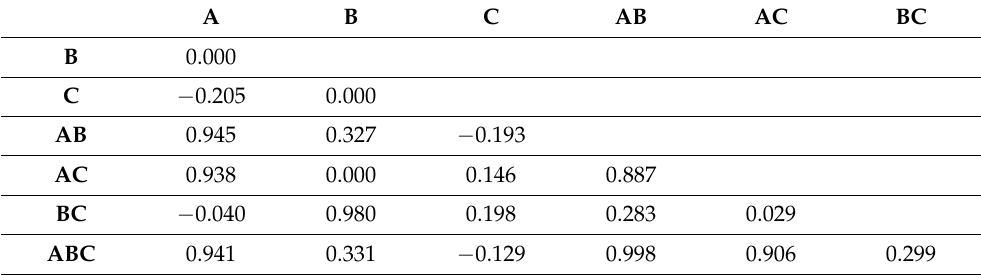
Table 2. Correlation matrix for EA (15, 3 1 5 1 7 1